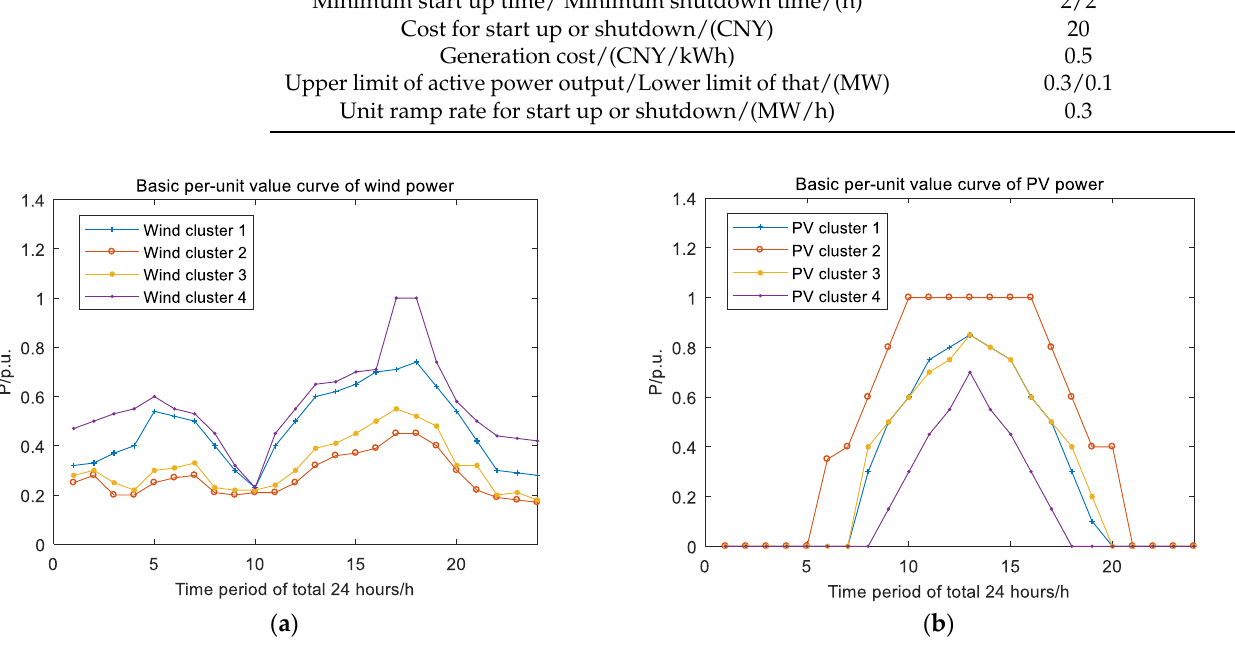
Figure 12. The basic per-unit value curve of output prediction. ( a ) Wind power; ( b ) PV power.